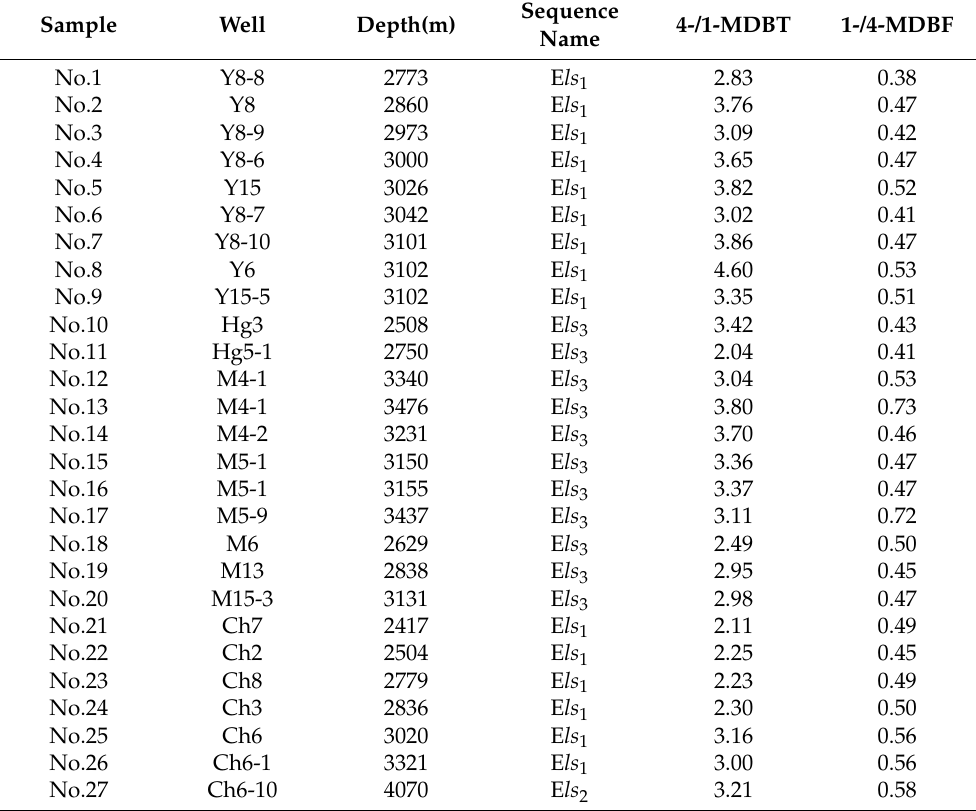
Figure 14. Interpreted seismic section (S-N direction) showing the consequent fault in the Chaoyang area.